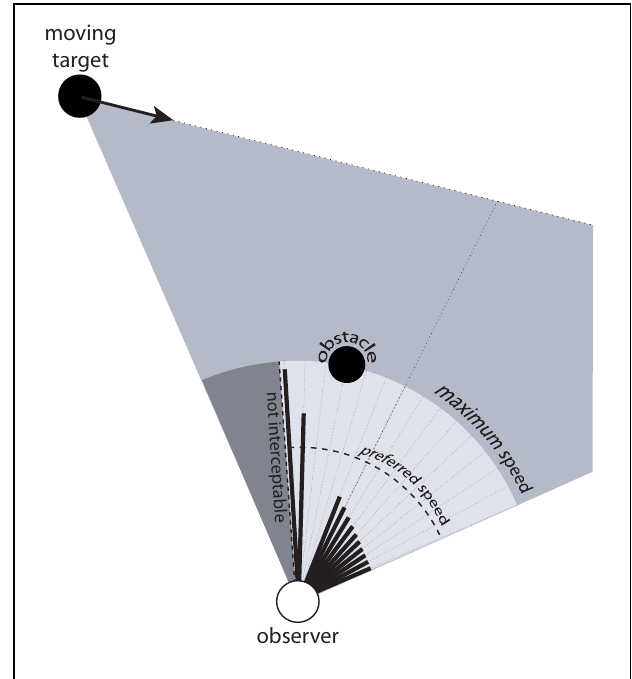
FIGURE 8 | Simultaneous interception of a moving target and avoidance of a stationary obstacle. Black lines emanating from observer indicate speed required to intercept moving target in each direction. Directions that would result in a collision with the obstacle are